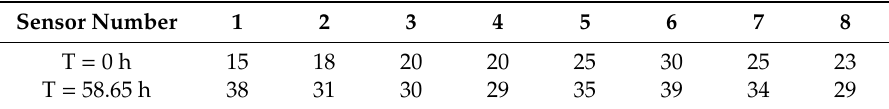
Table 2. The measured water contents at the start and end of the measurement (%). Sensor